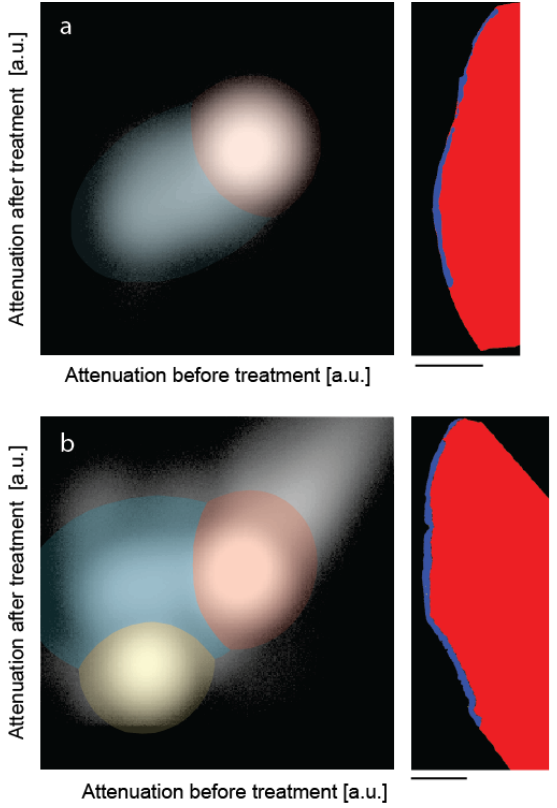
Figure 3. The joint histograms of the three-dimensional datasets allow segmenting the artificial lesions: ( a ) incubation of bare lesion and ( b ) incubation after peptide treatment. The selected virtual cuts through the sound enamel (red color) and the affected enamel (blue color) demonstrate the possibility of reliably segmenting the enamel lesion. The bar corresponds to the length of 500